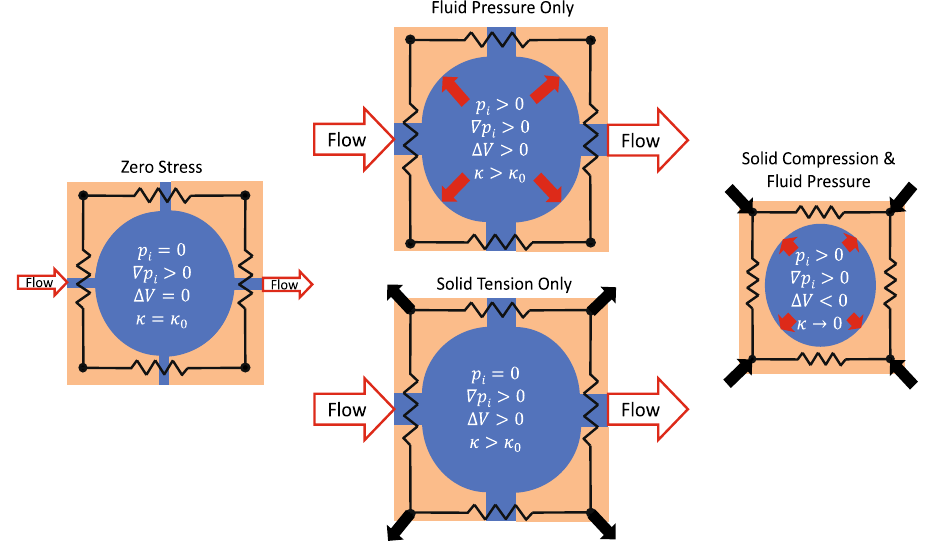
Figure 2. Schematic of tissue permeability dependence on volume changes that arise from the balance of fluid pressure and solid-state stress. A zero solid-state stress condition on the left is assumed to occur when IFP is near atmospheric pressure in the absence of external loading. Changes in either IFP or solid stress can change the pore space through which fluid can percolate leading to higher flow rates with the same gradient in IFP. Under conditions of sufficient solid-state compression on the right, the flow paths are highly restricted leading to minimal flow and the potential for increased fluid